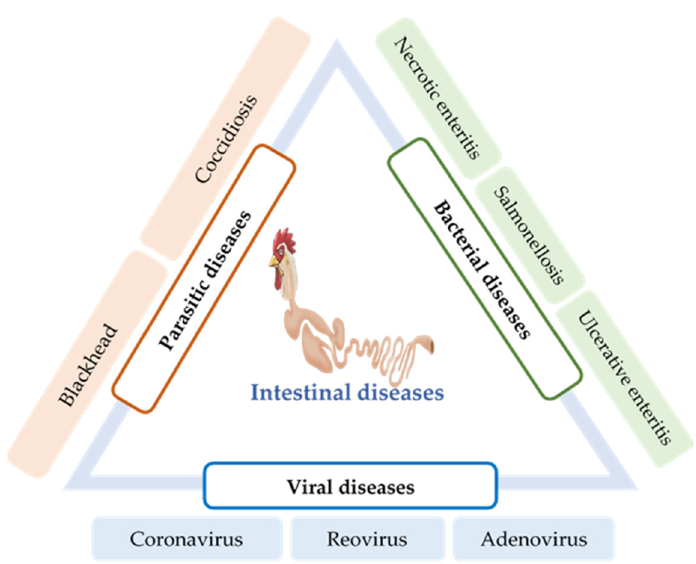
Figure 2. Major intestinal infectious diseases in poultry. Based on the nature of the causative agent, intestinal infections can be divided into three categories: parasitic, bacterial, and viral